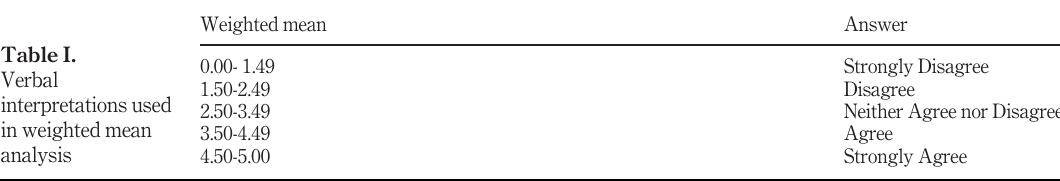
interpretations used in weighted